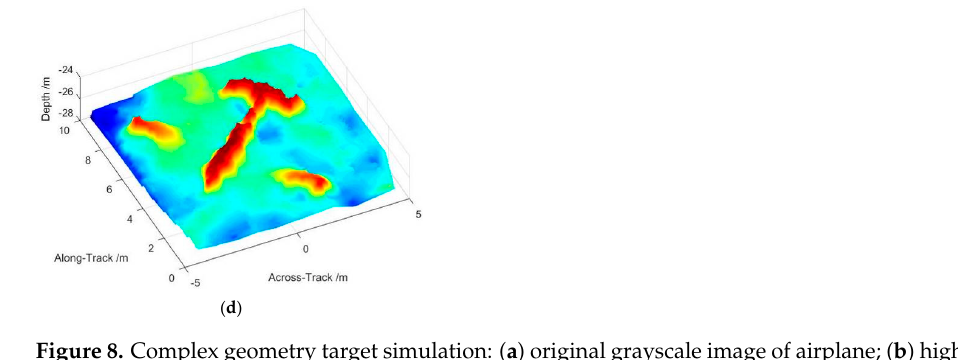
Table 2. Field experiment parameters of MBES. Parameters